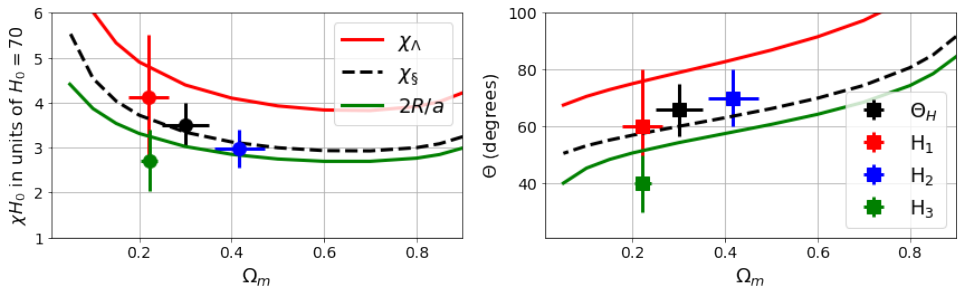
Figure 7. Comparison of the causal horizon H i sizes shown in Figure 6 and θ H from the homogeneity index [12] in comoving χ H 0 and angular units, given the mean measured Ω m and H 0 in each horizon. This is compared to the BHU predictions (2 R / a , green), χ § [8] (dashed) and χ Λ = r S / a (red) as a function of Ω m